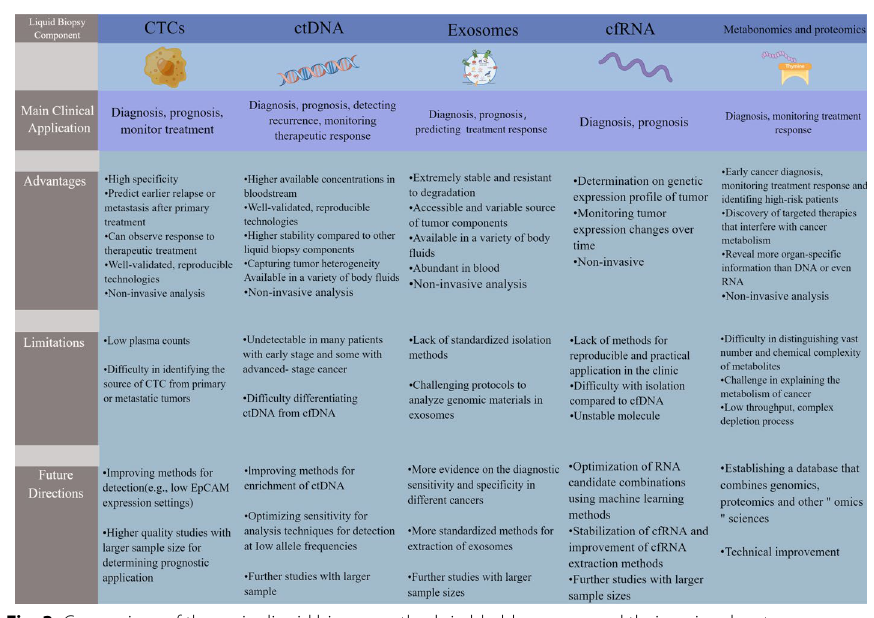
Fig. 3 Comparison of the major liquid biopsy methods in bladder cancer and their main advantages, limitations, clinical applications, and future